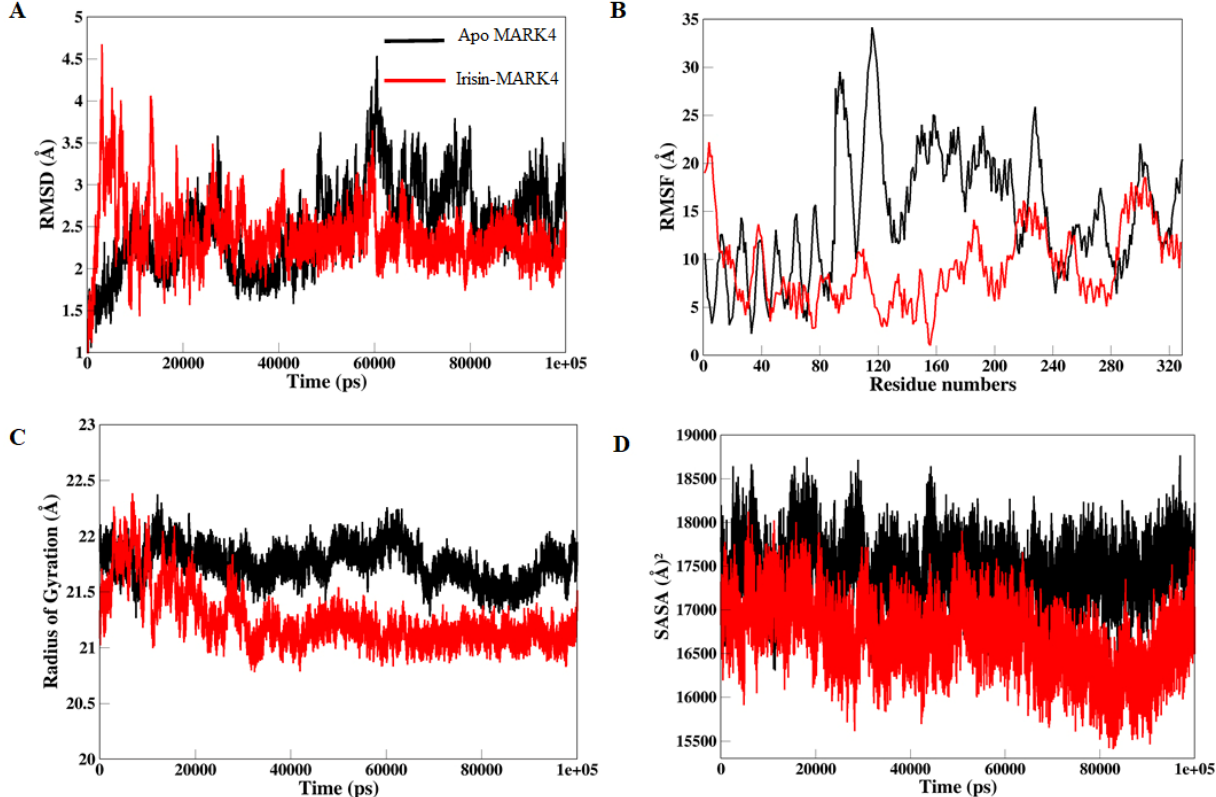
Figure 4. Structural dynamics of MARK4 apo (black color) and irisin bound MARK4 (black color) enzyme. ( A ) RMSD, ( B ) RMSF, ( C ) R g values, and ( D ) SASA values across Cα backbone in Å of apo MARK4 and irisin-MARK4 complex in Å across Cα backbone of both of the two conditions calculated after 100 ns of MD trajectories.